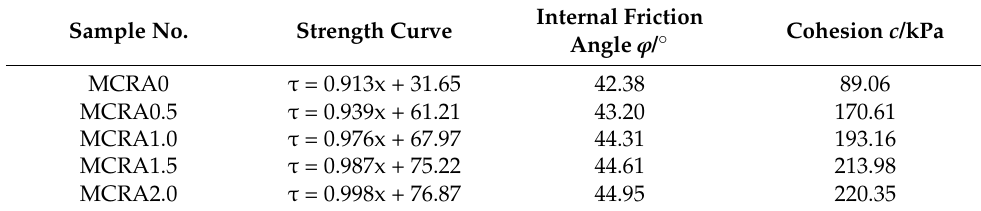
Table 5. Shear strength indexes of